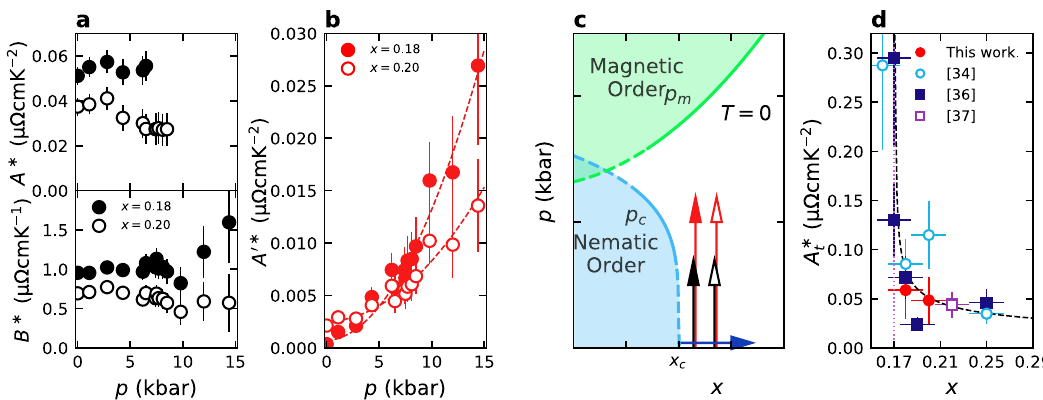
Fig. 3 Decoupled nematic and magnetic criticality in FeSe 1- x S x . a Renormalized A* coef fi cient (upper) and similarly renormalized B* coef fi cient (lower) as a function of pressure having rescaled A and B respectively by the pressure-induced change in ρ 0 . b Similarly renormalized A ′ * coef fi cient as a function of pressure. c Schematic T = 0 phase diagram in the p - x plane showing the nematic and magnetic phase boundaries. Vertical arrows indicate the pressure- induced approach of the two studied samples to the magnetic quantum critical point and the pressure ranges over which A and A ′ * can be determined. The horizontal arrow represents tuning away from the nematic quantum critical point (NQCP) with increasing x (relevant to panel d ). Near x = x c , the nematic phase boundary is shown as a dashed line to re fl ect its putative weak fi rst-order nature. d Variation of A t * , the total low-temperature T 2 coef fi cient at ambient pressure rescaled by the relative growth in the carrier density, and x beyond the nematic quantum critical point near x c ~ 0.17 (red dotted line) with data from this work and literature sources 33,36,37 . The error bars represent the estimated uncertainty in both x and the reported coef fi cients. We have estimated the error in the values reported in this work to be 50% due to the constraints on sample size in a pressure cell and 30% elsewhere. The uncertainty in x has been assumed to be ±0.015 and representative of the typical variation in x within an individual batch of samples 12 . See Supplementary Note 1 for details of the rescaling procedure. The dashed line is a guide to the